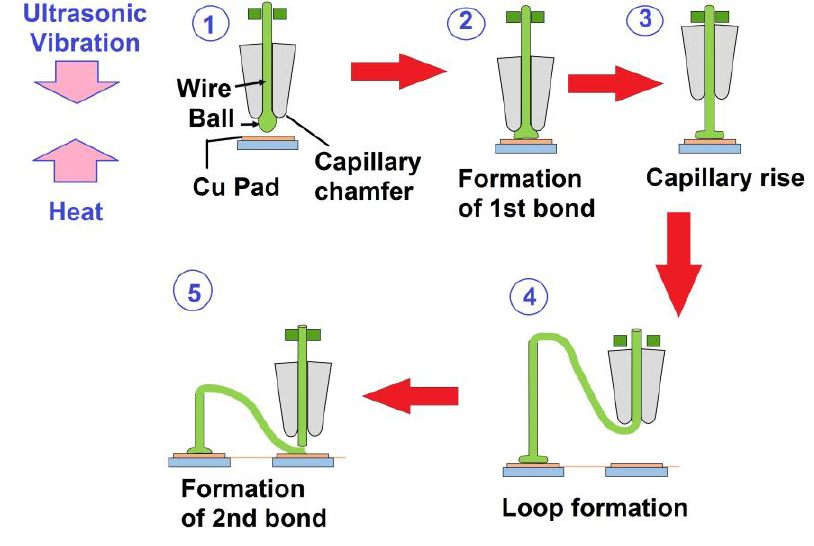
Figure 8. Schematic of the wire bonding process.